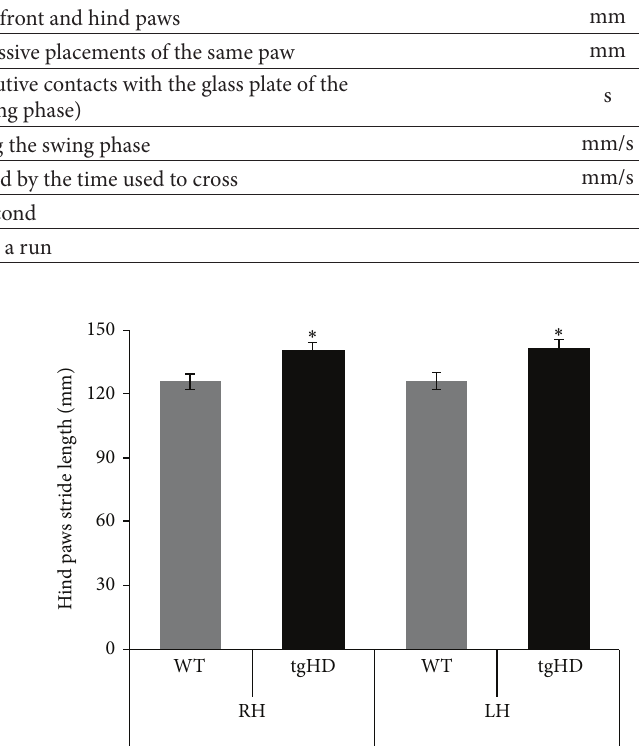
Figure 2: Static gait parameter—the graph represents the hind paws stridelengthin9-month-oldtransgenic(tgHD)andwild-type(WT) rats. RH: right hind paw; LH: left hind paw. The values are mean ± standard error of the mean (SEM) and statistically significant difference ( 𝑃 < 0.05 ) is indicated by an ( ∗